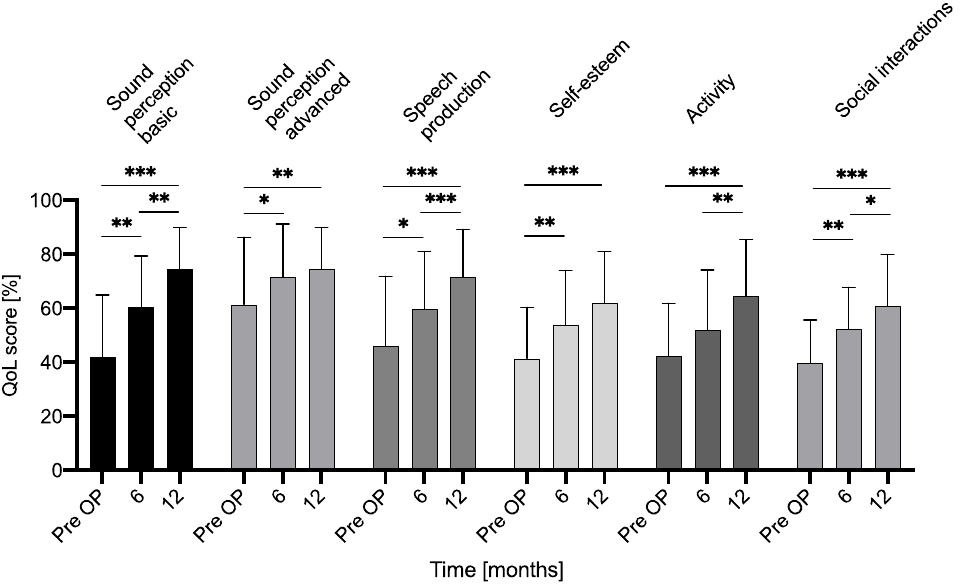
Figure 3. Results of Nijmegen Cochlear Implant Questionnaire before and 6 or 12 months after cochlear implantation in the whole patient cohort. Asterisks indicate a significant difference: * p < 0.05, ** p < 0.005, *** p < 0.0005. Figure 3 NCIQ QoL subdomain scores.